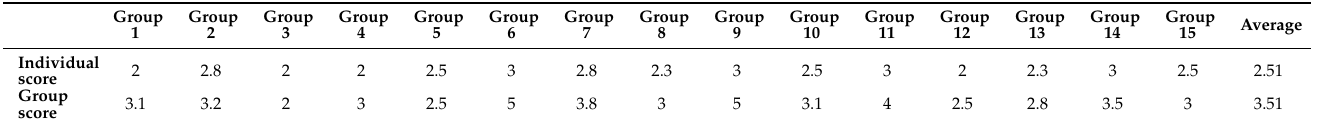
Table 5. Individual and group